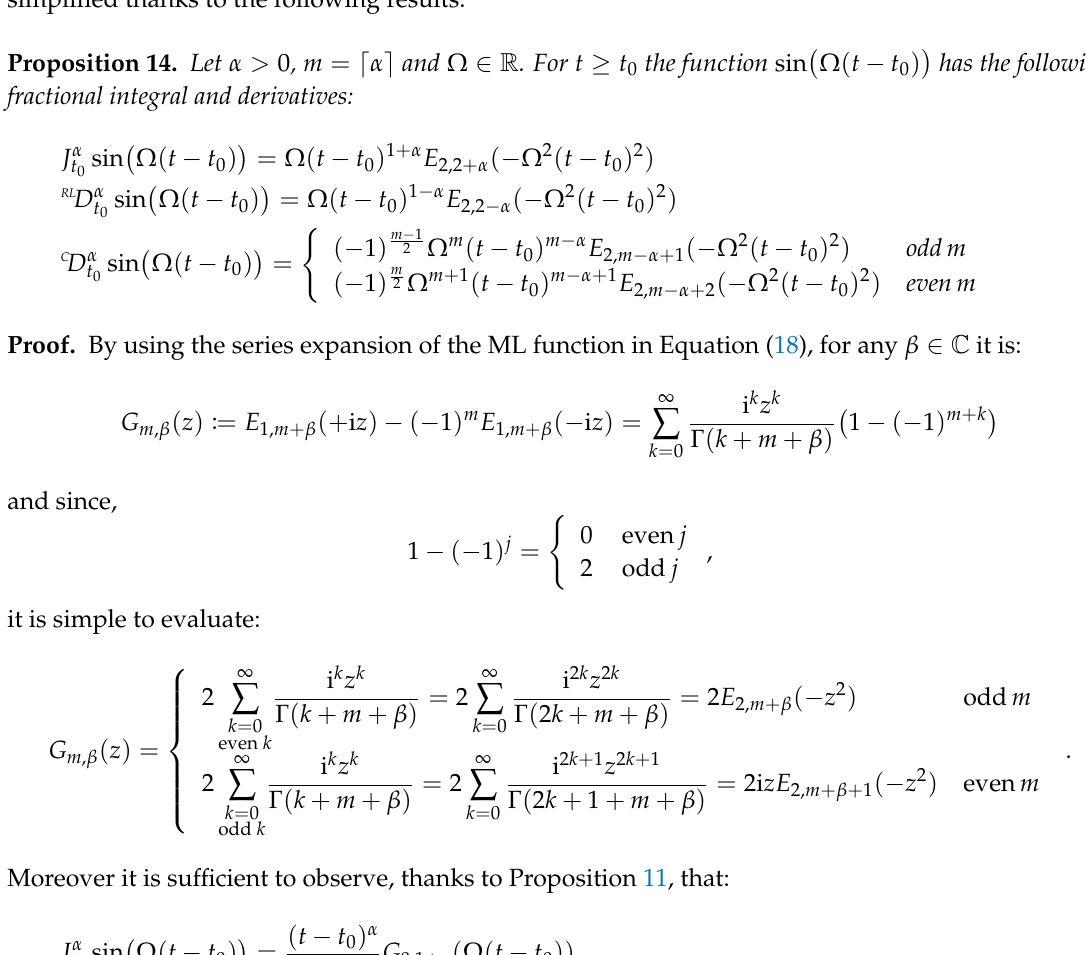
cos Ω t and C D α 0